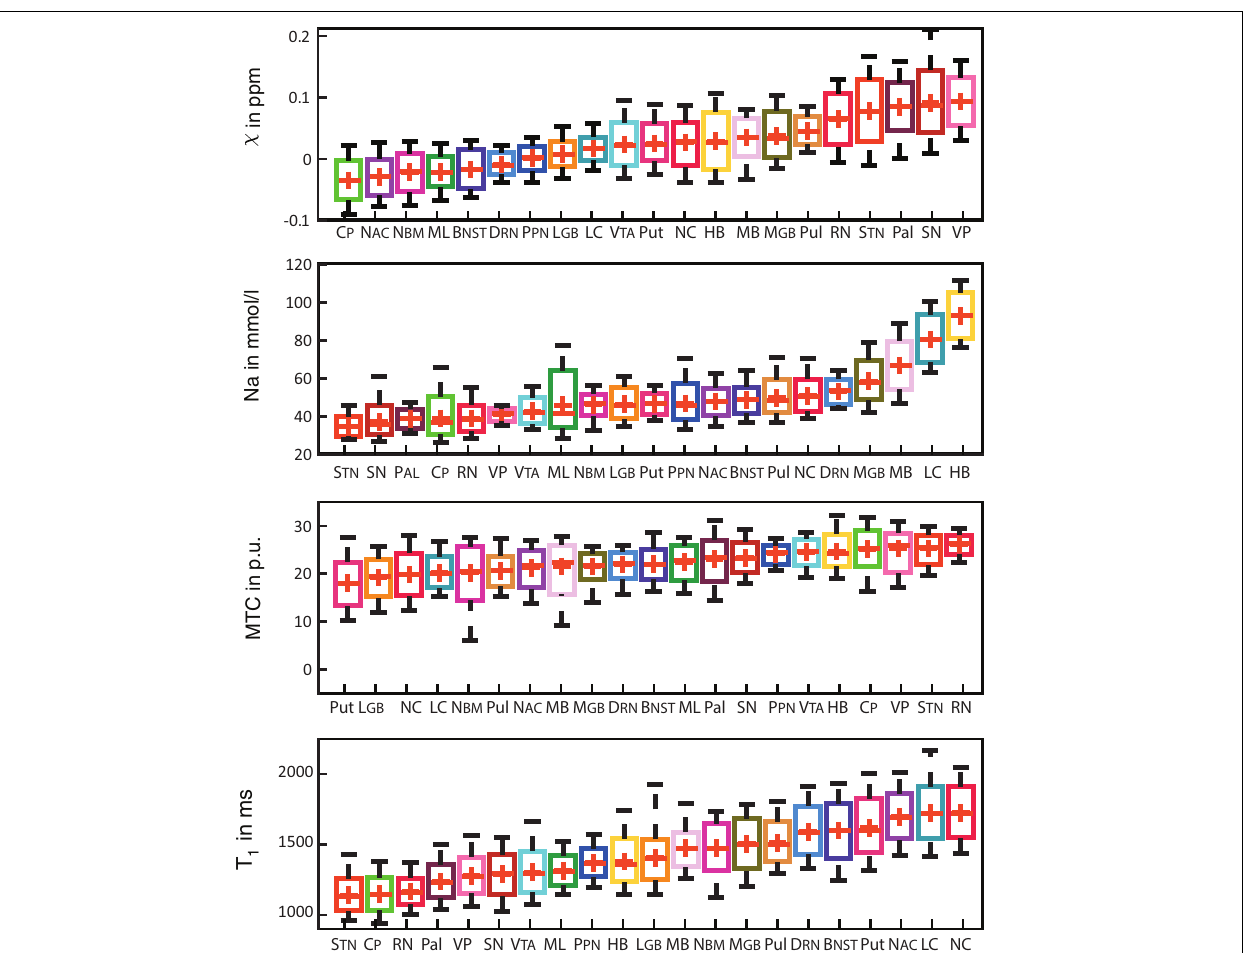
FIGURE 3 | Boxplots for each of the recorded contrasts displaying the voxel-wise signal in each subcortical structure in ascending order and colored according to Figure 1 . Additionally, mean values are indicated by a red cross for each structure and whiskers represent the 9th and 91st percentiles. (Epi-)thalamic nuclei including medial and lateral geniculate bodies (MGB and LGB), the pulvinar (Pul), and the habenula (HB) are colored in shades of yellow. Limbic nuclei including the ventral pallidum (VP), the nucleus basalis Meynert (NBM), the bed nucleus of the stria terminalis (BNST), the nucleus accumbens (NAC) and the mamillary body (MB) are colored in shades of pink. Nuclei of the ARAS including the ventral tegmental area (VTA), the pedunculopontine nucleus (PPN), the locus coeruleus (LC), and the dorsal raphe nucleus (DRN) are colored in shades of blue. Extrapyramidal nuclei including the substantia nigra (SN), the subthalamic nucleus (STN), the red nucleus (RN), the globus pallidus (Pal), the putamen (Put), and the nucleus caudatus (NC) are colored in shades of red. Fiber tracts including the cerebral peduncle (CP) and the medial lemniscus (ML) are colored in shades of